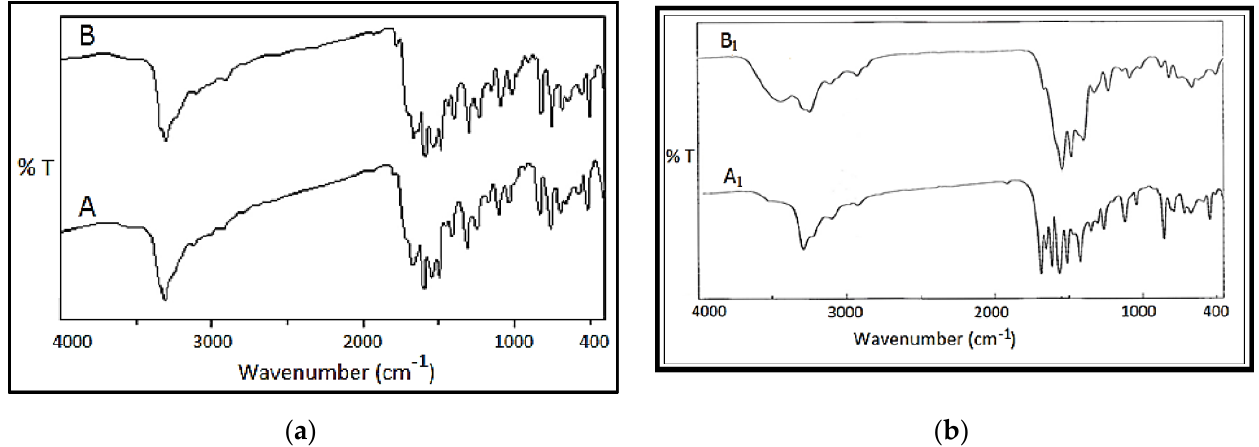
Figure 1. ( a ). FT-IR spectra of ligand before (B) and after (A) irradiation. ( b ) FT-IR spectra of the Pb (II) complexes before (B 1 ) and after (A 1 ) irradiation.